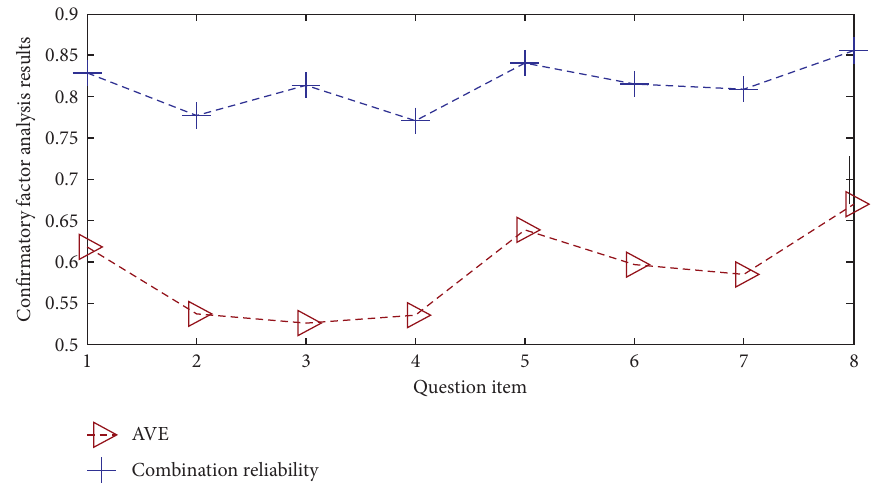
Figure 6: Confirmation factor analysis results of the gestation period